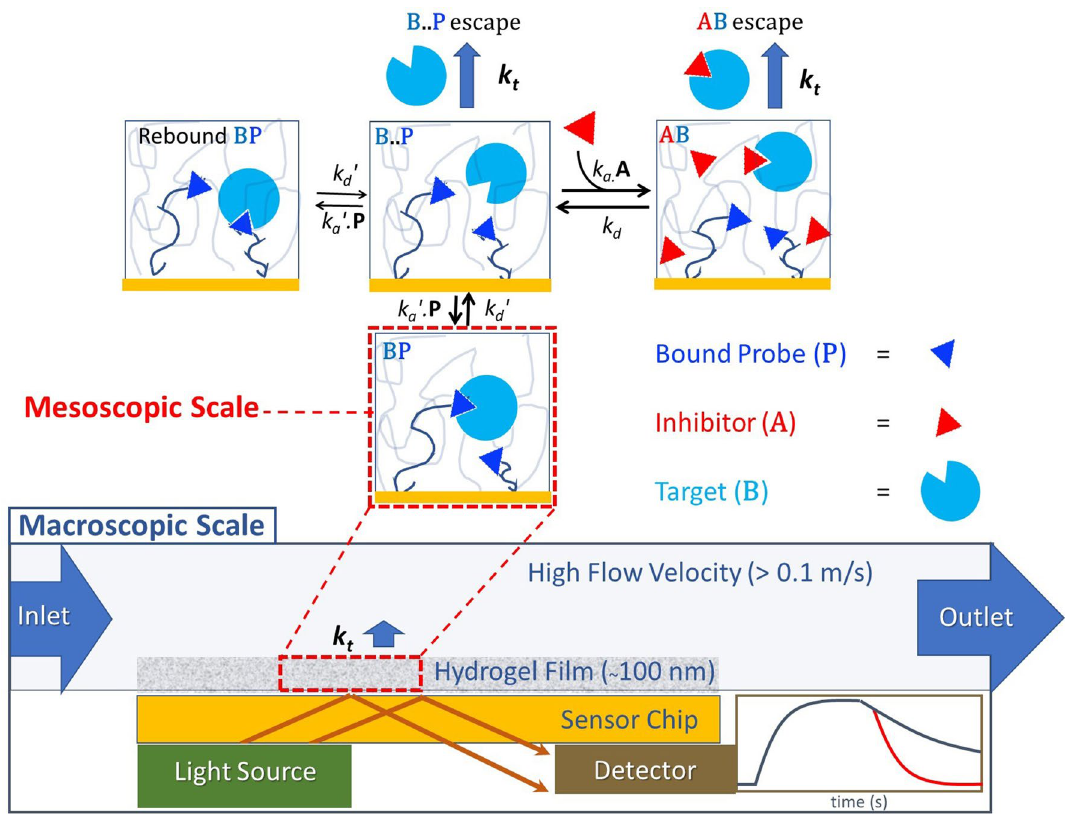
Figure 1. Reaction/diffusion pathways of the rebinding-assay for a flow injection-based biosensor. A macroscopic scale view (bottom) depicts a hydrogel bound to a sensor chip and interrogated by a label-free detector to produce a binding progress curve with (red), and without (blue), inhibition of rebinding during the dissociation phase. A series of mesoscopic scale views of the hydrogel (four upper panels) depict the reaction pathways. The hydrogel polymer is depicted here as random loops derivatized to possess a high concentration of P (blue triangle), which is competitive with inhibitor A (red triangle) in binding to target B (blue circle). Paired forward- and reverse-rate constants for formation of BP and AB are k a ′ (M −1 s −1 )/ k d ′ (s −1 ) and k a (M −1 s −1 )/ k d (s −1 ), respectively, while k t (s −1 ) is the mass transport coefficient that defines the hydrogel escape rate. The molecular contacts stabilizing BP dissociate releasing B to become a transient unbound species B..P that can readily reform BP , pairing with any P in its vicinity. Multiple rebinding cycles are favored at